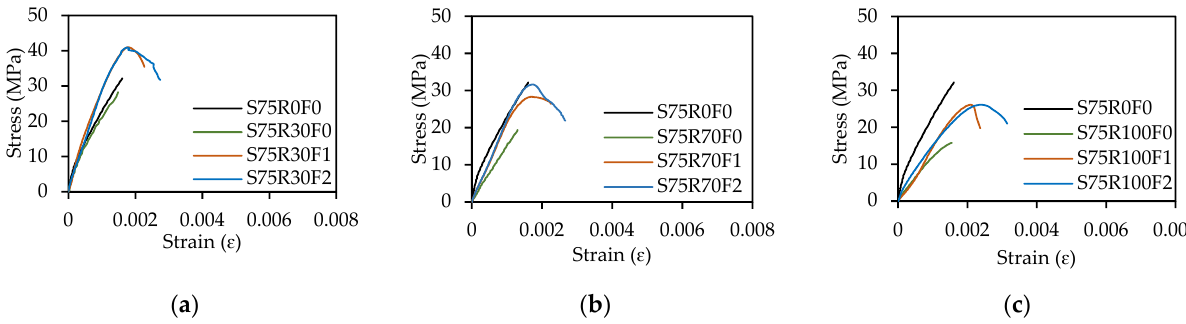
Figure 10. Typical compression stress-strain curves of RCA alkali-activated slag-fly ash (3:1) concrete mixtures with RCA replacement of ( a ) 30%, ( b ) 70%, and ( c ) 100%.